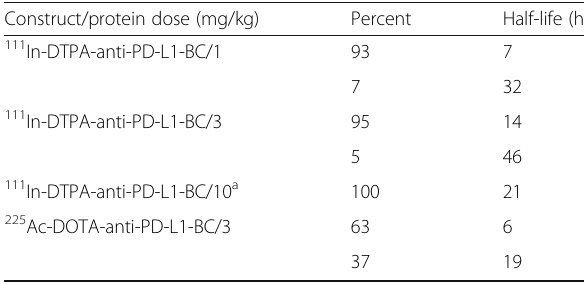
Table 1 Summary of blood pharmacokinetics Construct/protein dose (mg/kg) Percent Half-life